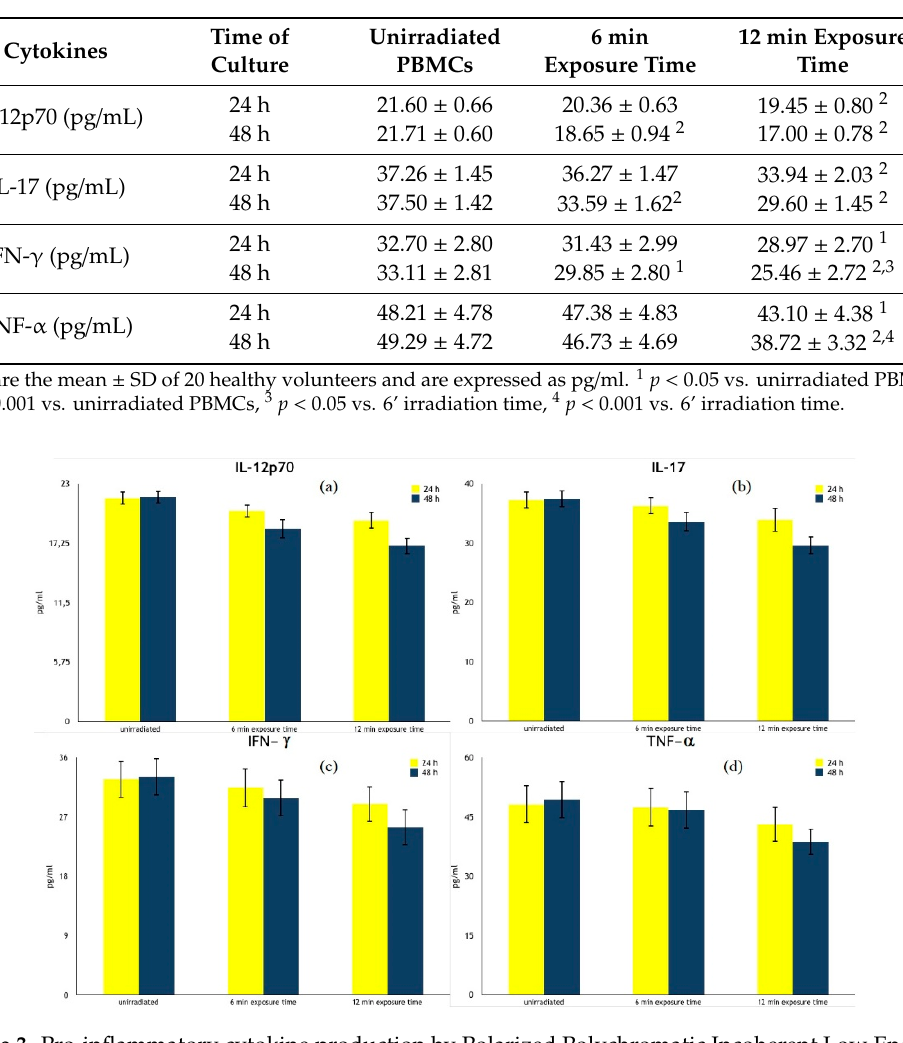
Figure 3. Pro-inflammatory cytokine production by Polarized Polychromatic Incoherent Low Energy Radiation (PILER) exposed and cultured human peripheral blood mononuclear cells (PBMCs). The results are expressed as the means of cytokine levels ± SD of 20 healthy volunteers and are expressed as pg/mL. ( a ) IL-12p70; ( b ) IL-17; ( c ) IFN- γ ; ( d ) TNF- α .